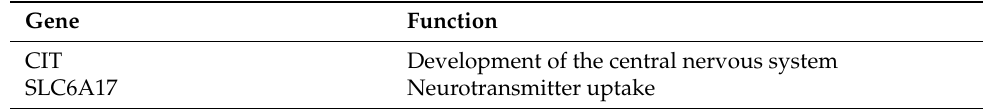
Table 3. Neuronal gene and its function selected by integration